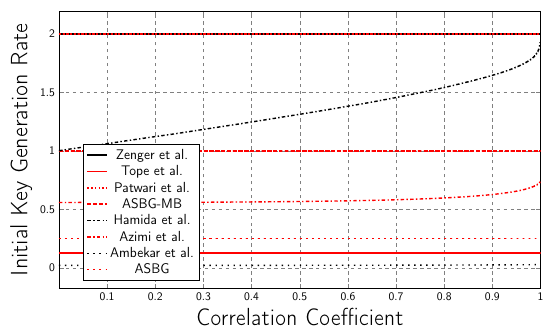
Figure 4: Initial key generation rate versus correlation coef- ficient for different quantization